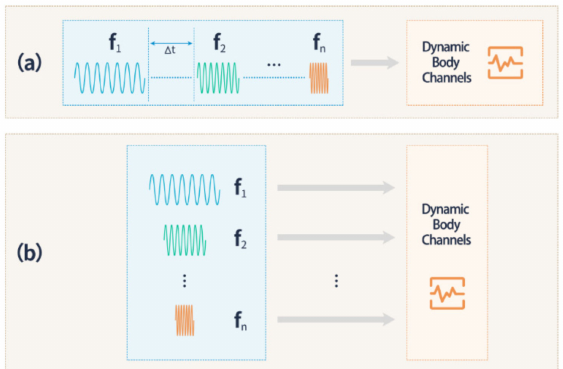
Figure 1. ( a ) Traditional sequential measuring scheme. ( b ) A novel parallel measuring strategy. ∆ t represents the time interval when sweeping different frequencies, called the temporal resolution, and ∆ t = 0 in the parallel measuring